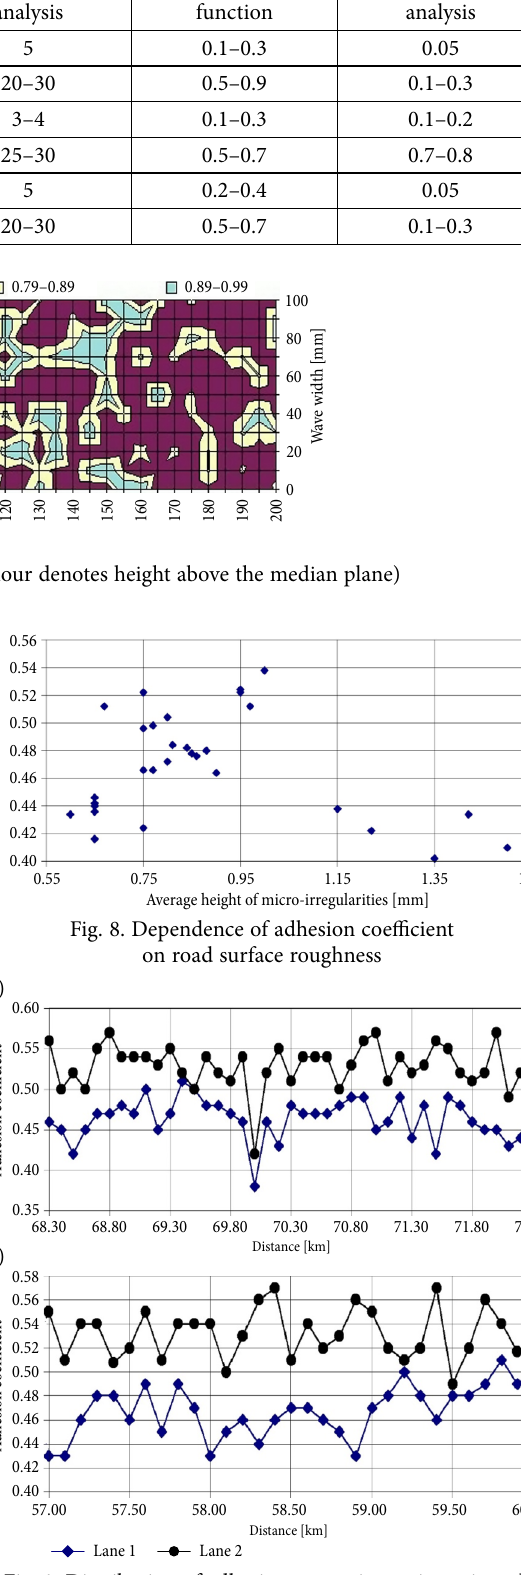
Fig. 9. Distribution of adhesive properties on investigated highway lanes: a – stretch X1, b – stretch